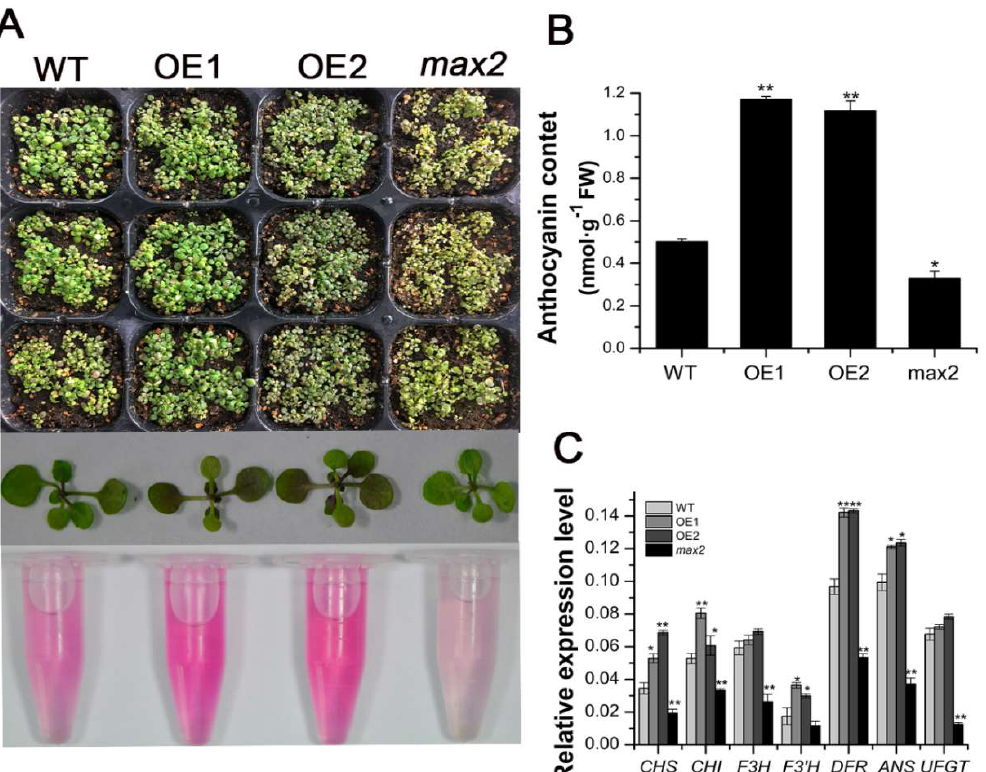
Figure 4. SsMAX2 promoted anthocyanin accumulation in Arabidopsis leaves under drought stress. ( A ) Drought-induced anthocyanin accumulation in the leaves; ( B ) Anthocyanin level of different lines; ( C ) Relative expression of anthocyanin biosynthesis genes in the leaves of different lines in response to drought stress. Data are presented as means ± SD of three biological replicates. Significant differences between WT and the other groups were determined by Student’s t -test. Significance level: * p < 0.05, ** p < 0.01.